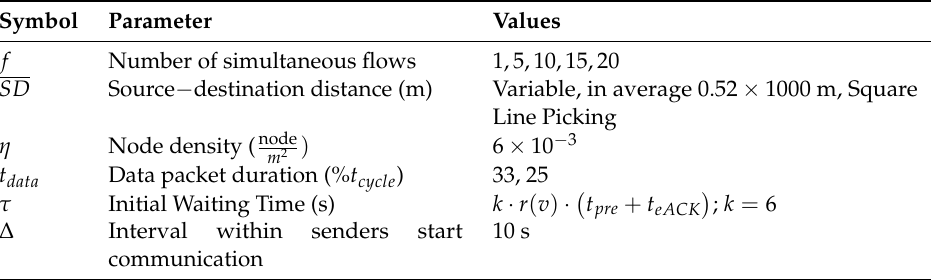
Table 5. Parameters used for simulation with multiple flows.